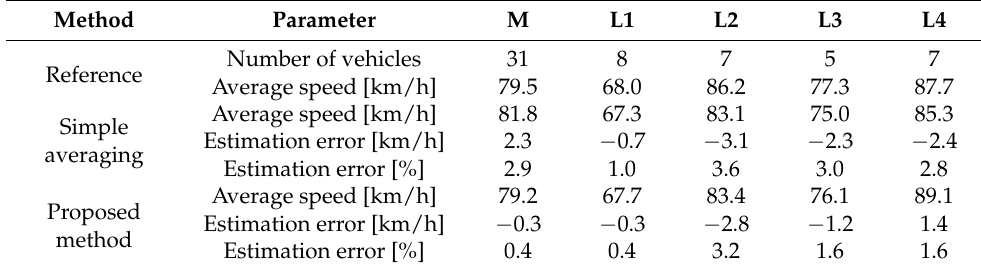
Table 1. Results of vehicle speed estimation with the proposed